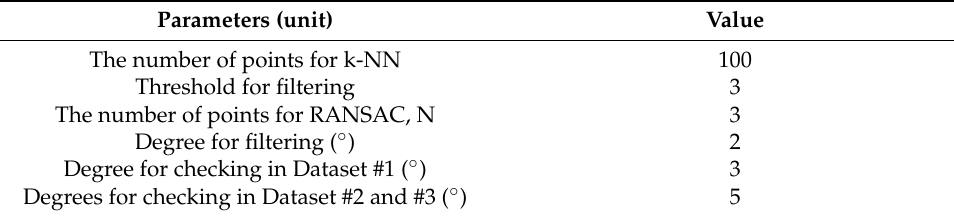
Table 2. Parameters of the case study. Parameters (unit) Value The number of points for k-NN 100 Threshold for filtering 3 The number of points for RANSAC, N 3 Degree for filtering ( ◦ ) 2 Degree for checking in Dataset #1 ( ◦ ) 3 Degrees for checking in Dataset #2 and #3 ( ◦ )